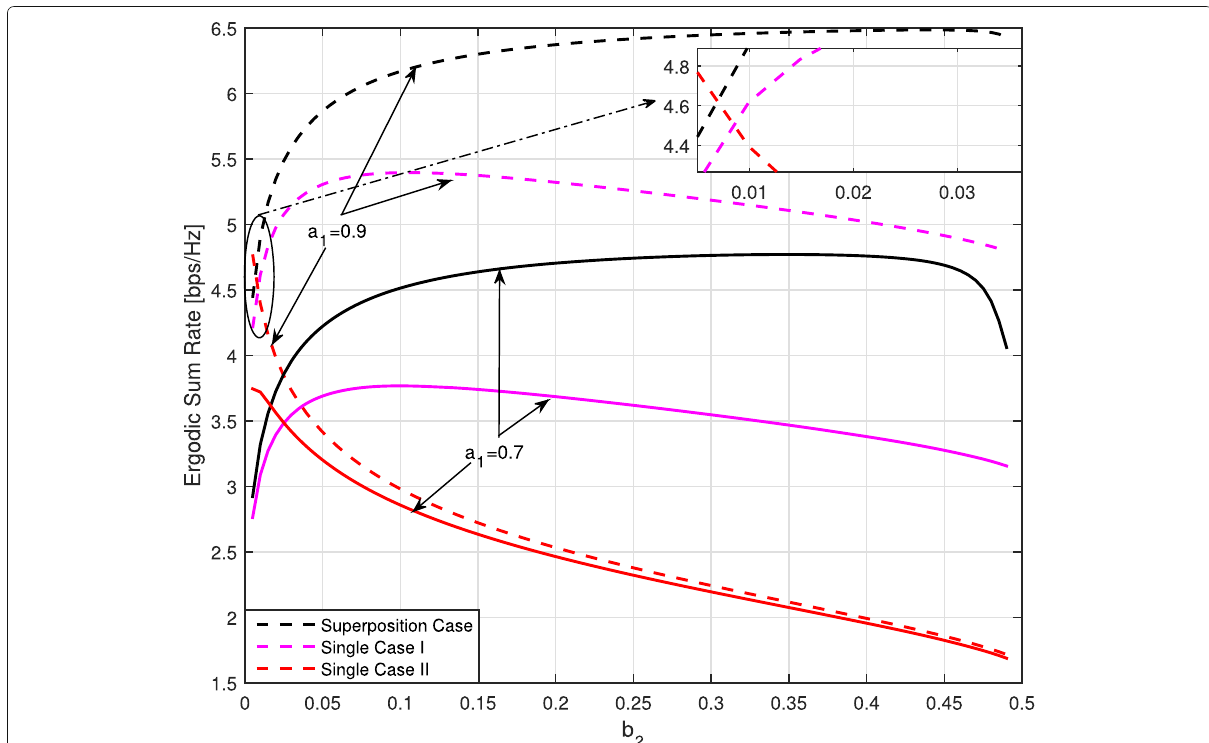
Fig. 7 The ergodic SRs achieved by our proposed CTRS-NOMA single case I, CTRS-NOMA single case II, and CTRS-NOMA superposition case versus power allocation factors b 2